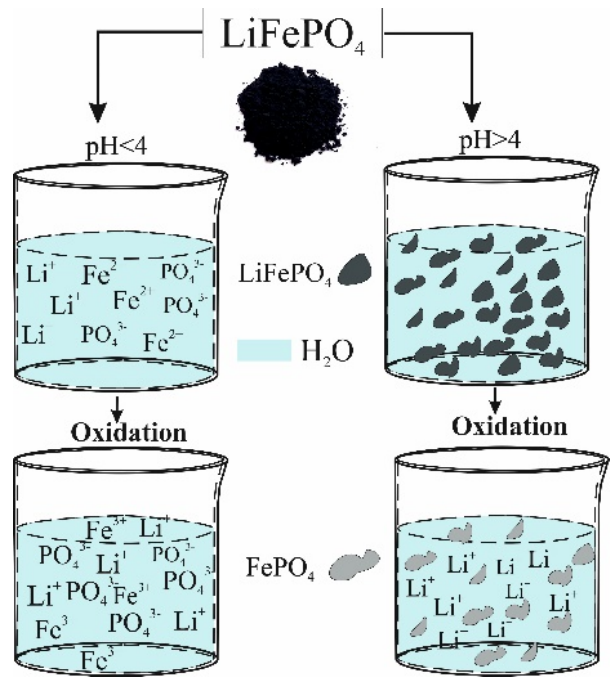
Figure 1. Scheme of LiFePO 4 oxidation in an aqueous medium at different pH.